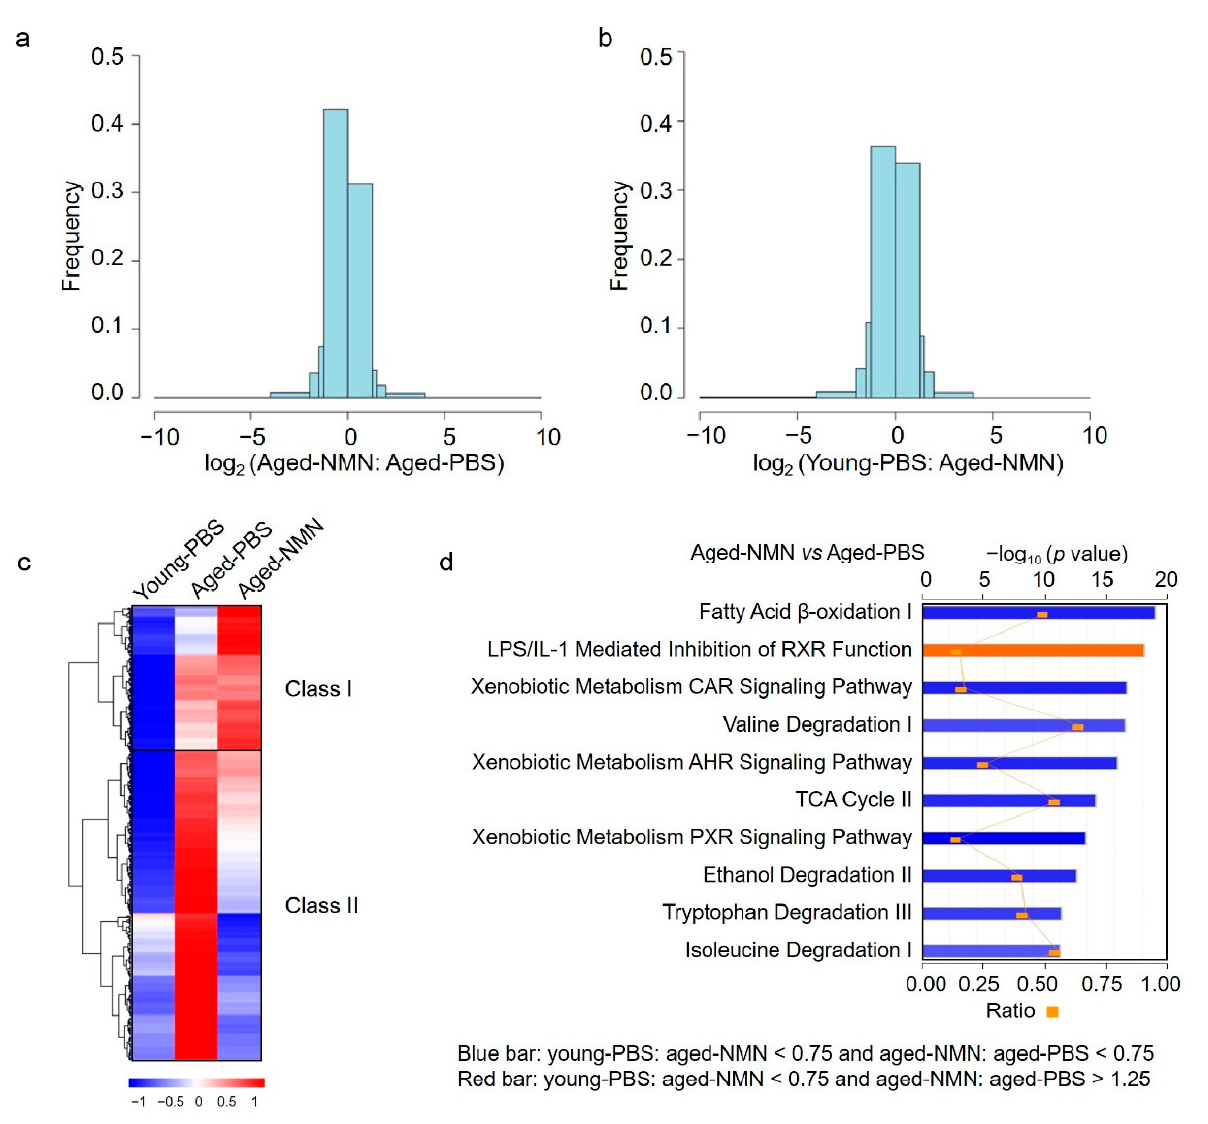
Figure 5. NMN changed aging-related acetylome. ( a ) Frequency distribution showed more acetylated peptides were identified in PBS-treated than NMN-treated aged mice. x axis was blocked at − 10, − 4, − 2, − 1.5, − 1.25, 0, 1.25, 1.5, 2, 4, 10. ( b ) Frequency distribution showed similar numbers